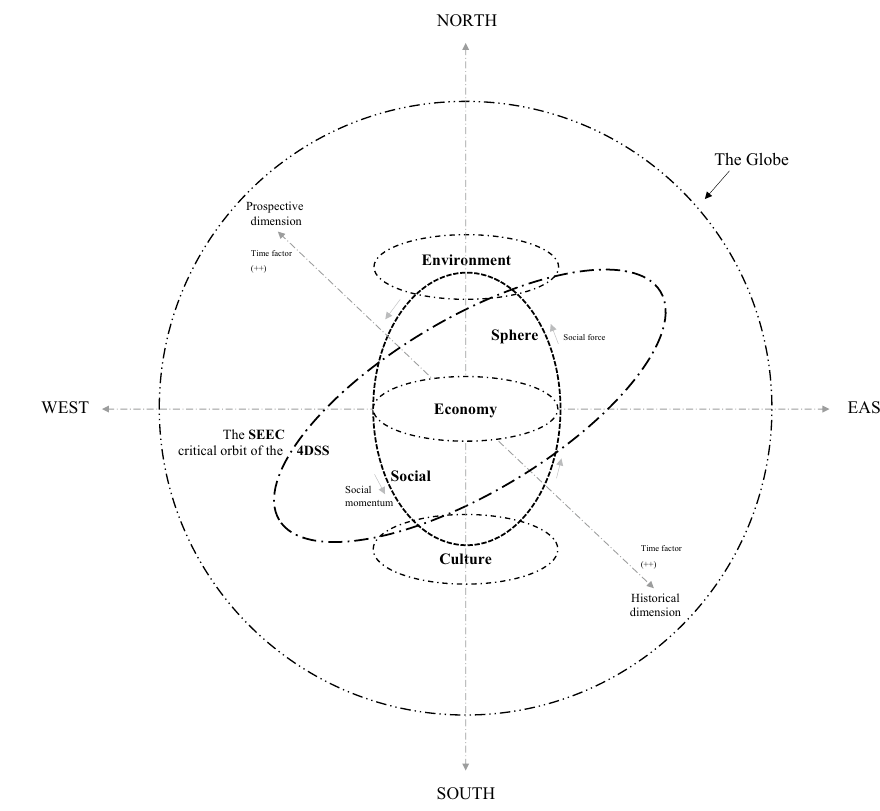
Fig. 6 Model 3: Harmonized socially-driven